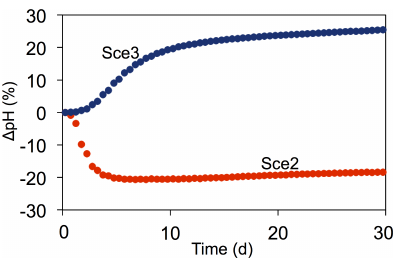
Figure 4. pH differences in the surrounding porous medium. pH is computed 15m far away from the underground reservoir in the downstream